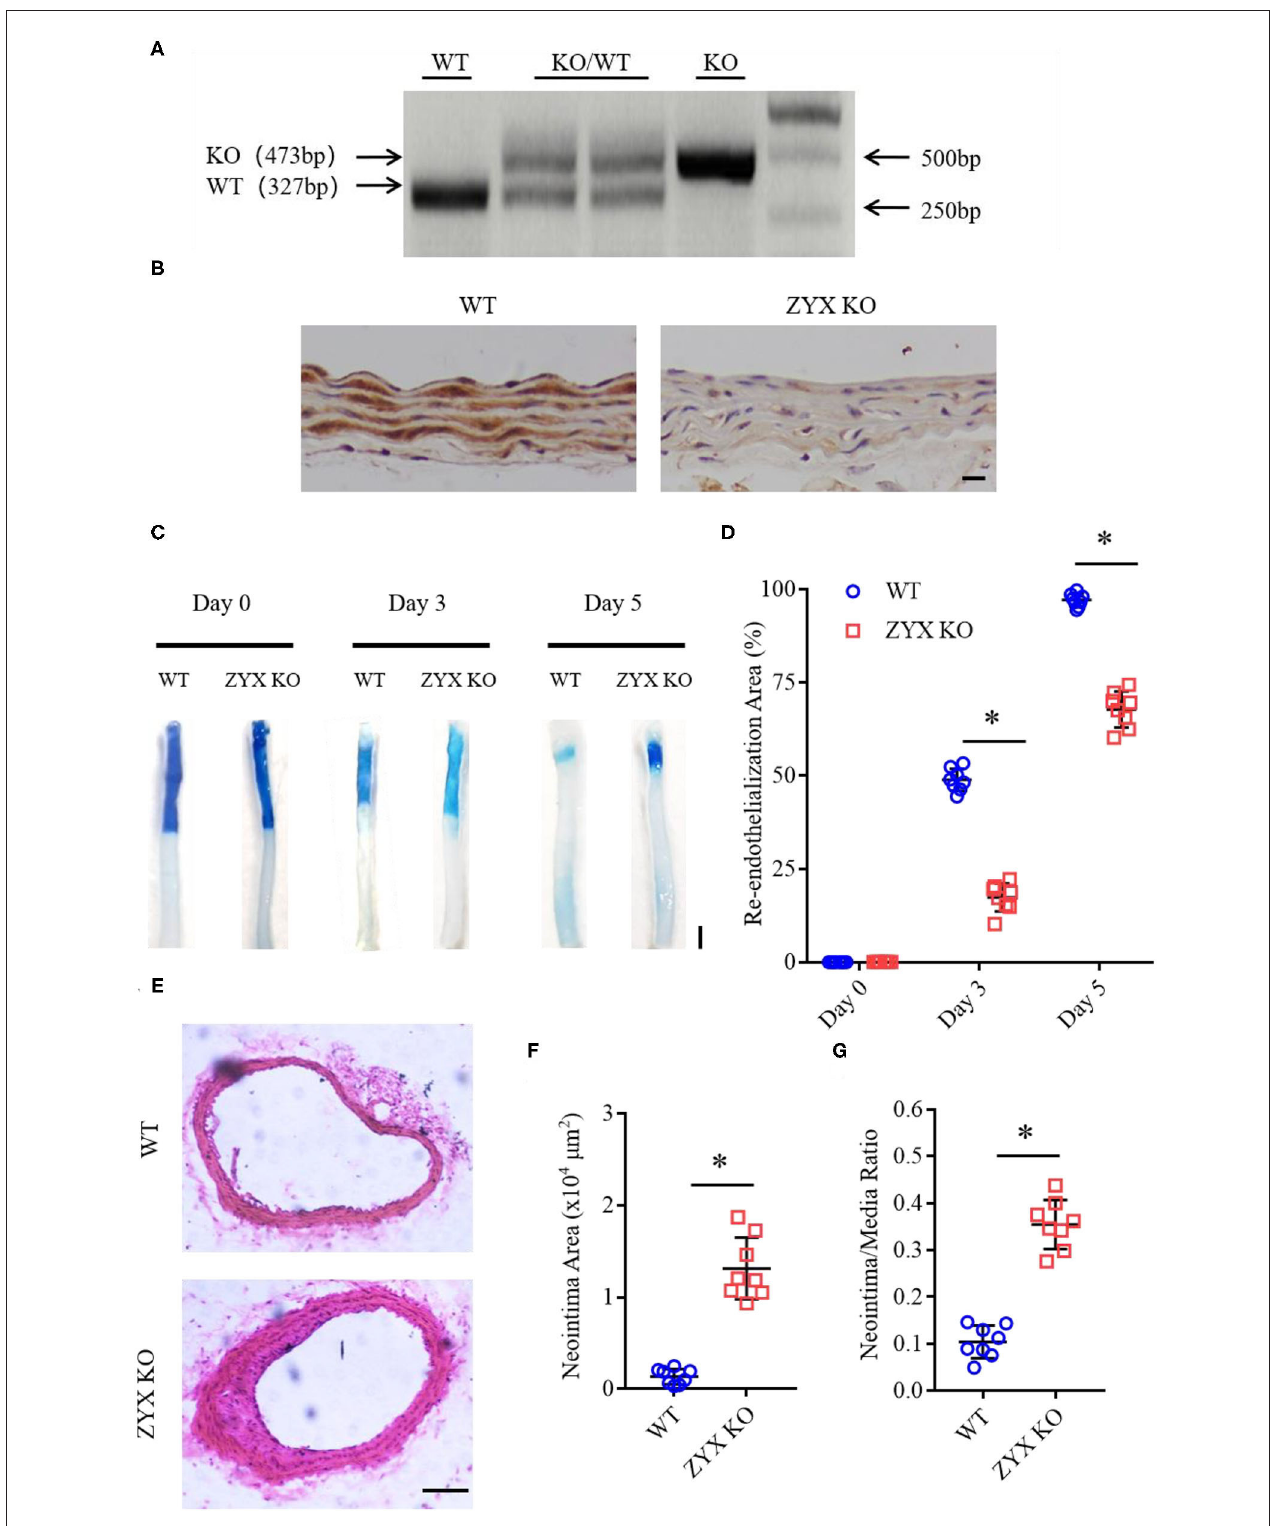
FIGURE 1 | Zyxin deficiency delays re-endothelialization and promotes neointima formation in wire-injured mice carotid arteries. (A) Results of genotyping polymerase chain reaction (PCR) for WT and ZYX KO mice (KO for 473 bp, WT for 327 bp). (B) Immunohistochemistry (IHC) staining of zyxin in the WT and ZYX KO mice (scale bar, 10 µ m). (C) Representative image of re-endothelialization assessed by Evans blue staining showing endothelial denudation of carotid arteries 0, 3, and 5 days after